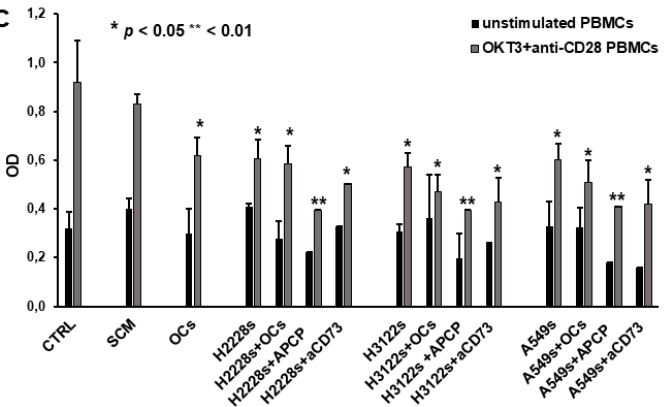
Figure 4. Effect of NSCLC CSC cells on OC activity and T-cell proliferation. ( A ) Bars indicate the activity of OCs, expressed as mean area of resorption ± SD. The presence of H3122 and, above all, of A549 NSCLC CSC spheres stimulates OCs, p < 0.05, while H2228s inhibit OC activity. ( B ) The release of TRAP by OCs was slightly increased in the presence of NSCLC spheres. ( C ) The assay measured the effect of the conditioned medium, derived from the different culture conditions, on T-cell proliferation, unstimulated and stimulated with anti-CD3 (OKT3) and anti-CD28 antibodies for 72 h. CTRL indicates T-cell proliferation in RPMI 1% FBS, SCM is the stem MTT cell medium. Data are represented as mean value ± SD of four independent experiments from each cell line. * indicates the significance compared to the CTRL calculated by one-way Anova analysis.